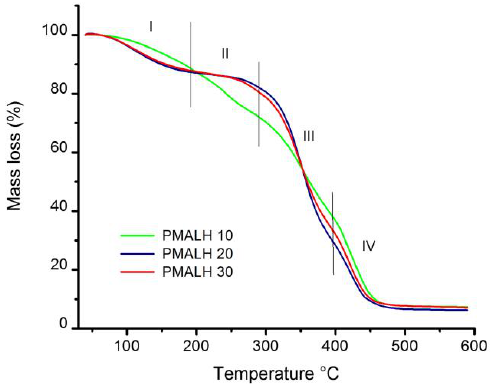
Figure 4. TGA (Thermogravimetric) thermogram for polyvinilalcohol (PVA) crosslinker with MAL.